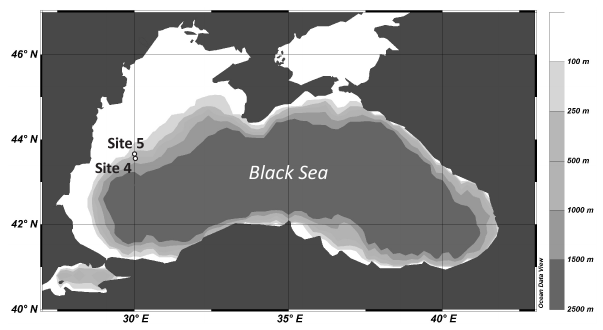
Figure 1. Map showing the locations of site 4 (43 ◦ 40.6 (cid:48) N, 30 ◦ 7.5 (cid:48) E; 377mb.s.s.) and site 5 (43 ◦ 42.6 (cid:48) N, 30 ◦ 6.1 (cid:48) E; 178mb.s.s.), sampled in June